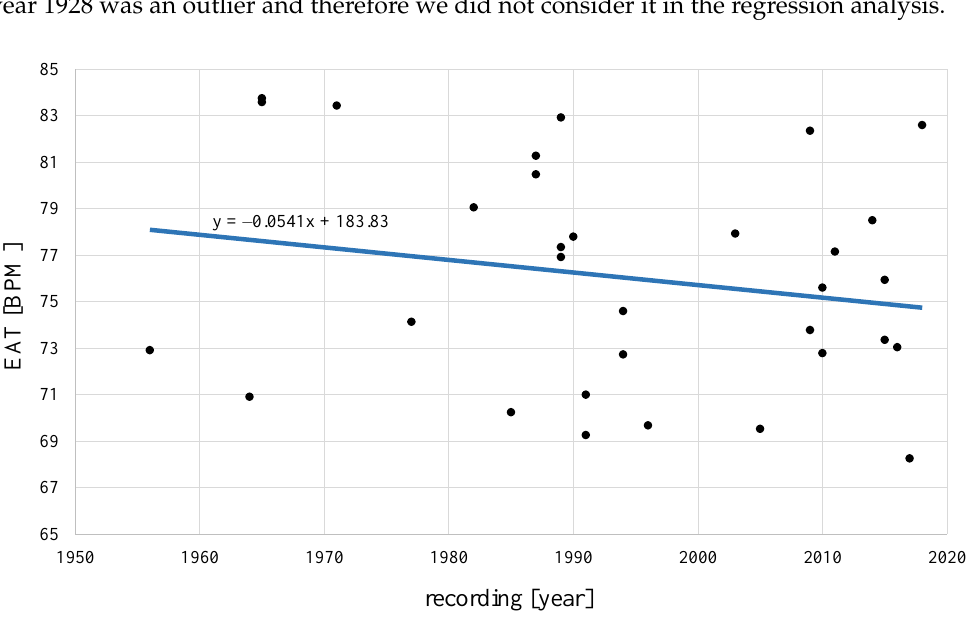
Figure 11. Results of the EAT calculation for the first motif of the string quartet database.